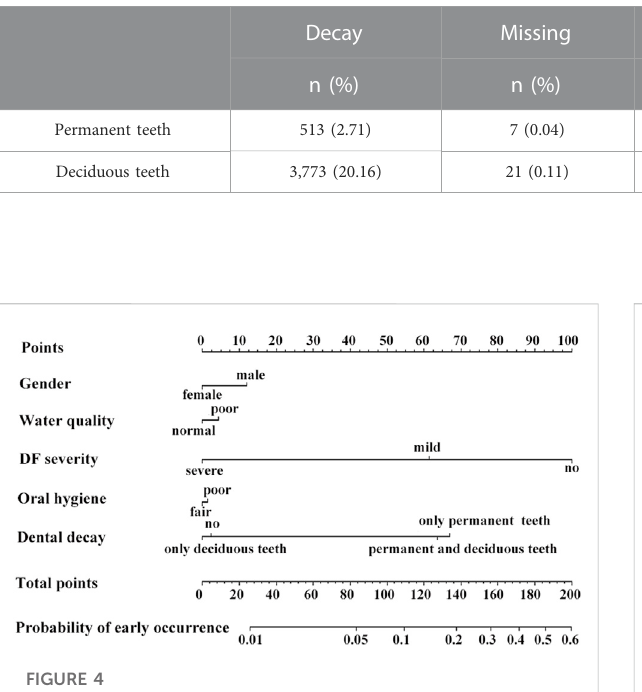
FIGURE 4 Nomograms to predict the probability of MIH occurrence. Non- DF had a signi fi cant in fl uence on MIH occurrence, which decreased with increasing DF severity. Dental decay had a certain effect on it. However, exposure to low-quality shallow underground water did not increase the likelihood of developing MIH.